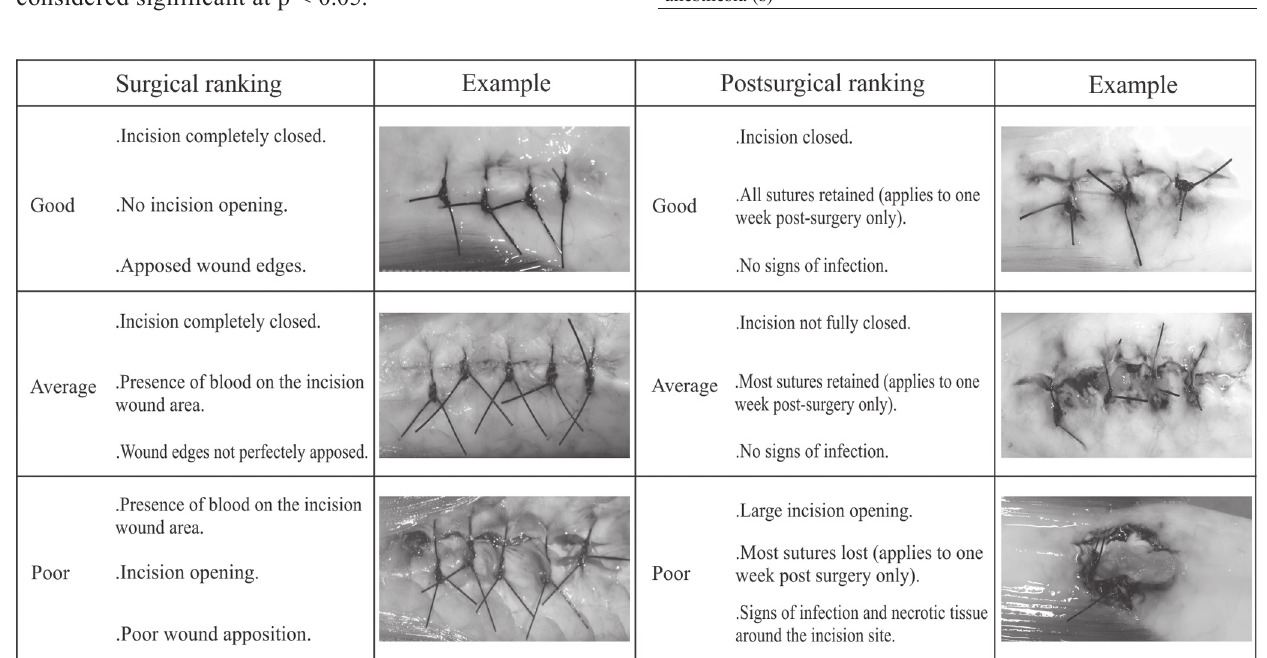
Fig. 1. Criteria and examples for the surgical and postsurgical